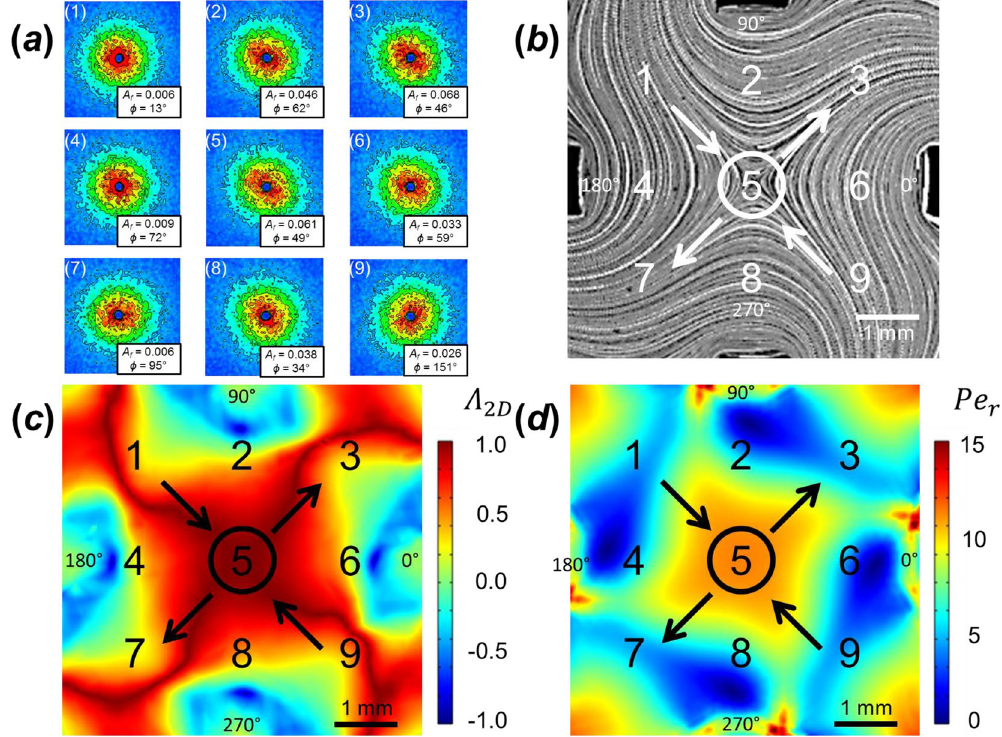
Figure 14. Flow field scan of CNC dispersion in FFoRM under extensional flow conditions ( Pe r = 10, 〈 Λ 2 D 〉 = 0.95). Numbered SANS spectra ( a ) correspond to the approximate location of the neutron beam (indicated with the D = 1 mm circles around the stagnation point region, 5) in the flow field ( b ) streaklines, ( c ) flow type parameter and ( d ) Pe r . Streaklines, flow type parameter, and Pe r are shown at the center plane of the device and correspond to the experimental conditions of the SANS measurements with inflow and outflow directions indicated with arrows. Streaklines were generated from experiments while flow type parameter and Pe r fields were generated from simulations. In the SANS spectra, blue color denotes low intensity while red denotes high intensity. Calculated A f and φ are included underneath the corresponding